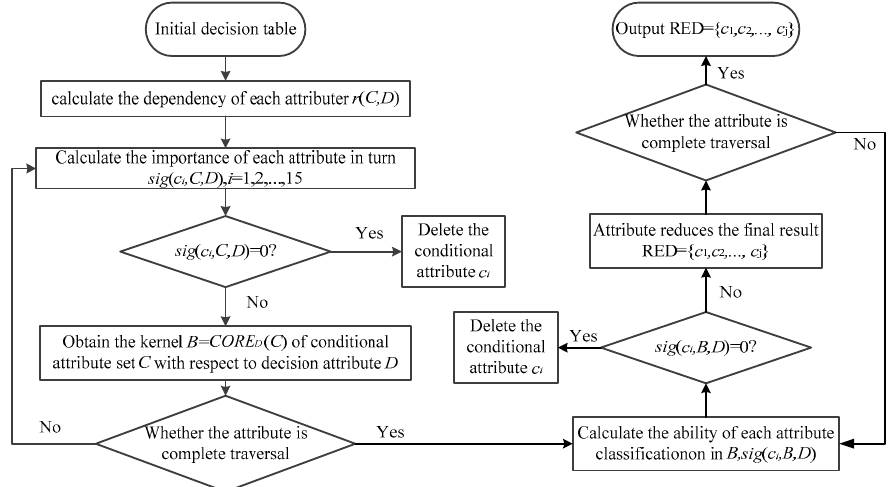
Figure 2. Attribute reduction flow chart based on attribute significance.